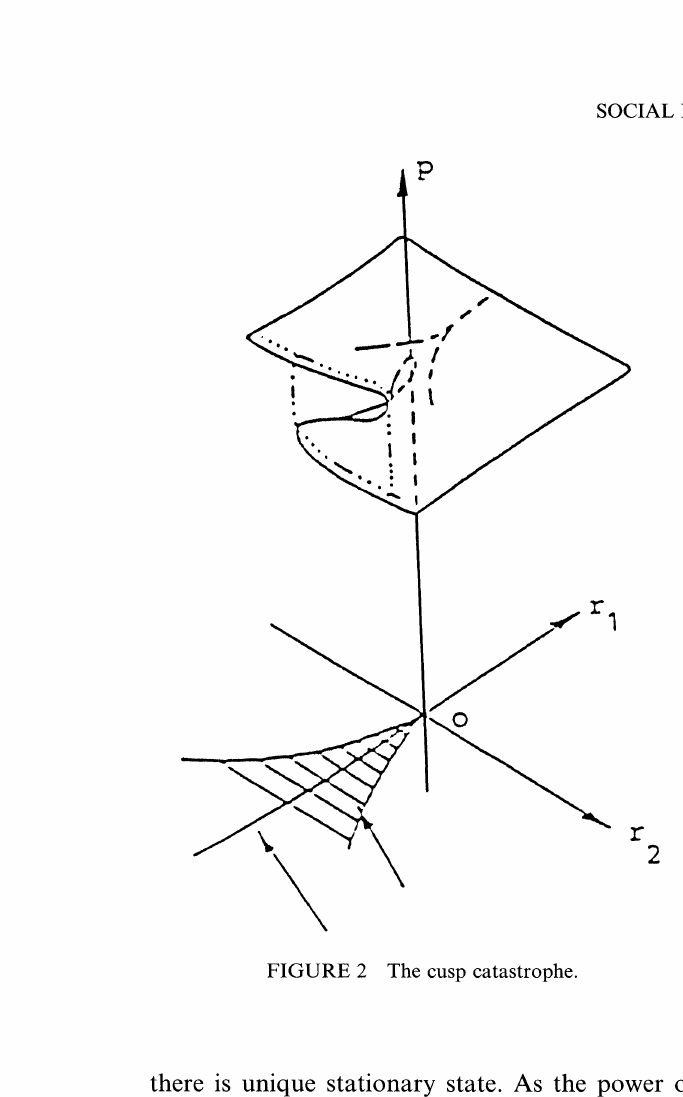
FIGURE 2 The cusp catastrophe.